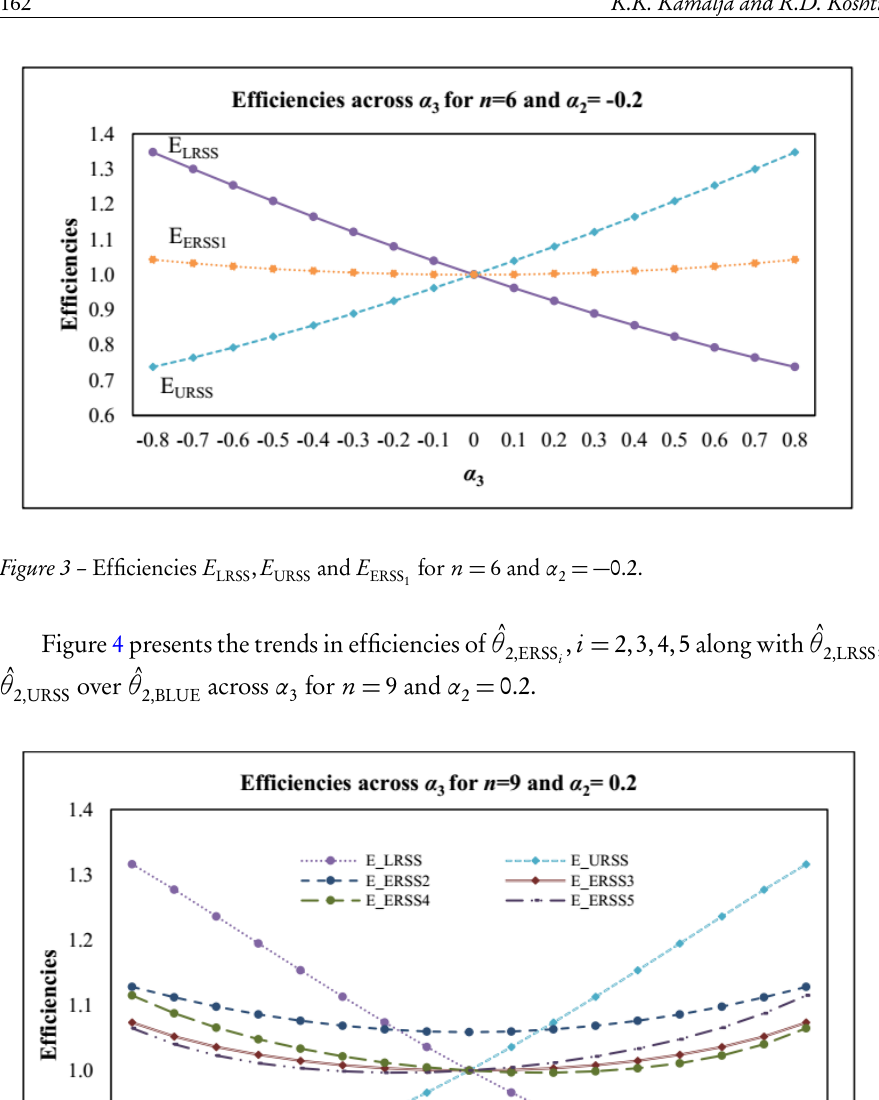
, E and E , i = 2,3,4,5 for n = 9 and α LRSS URSS ERSS i